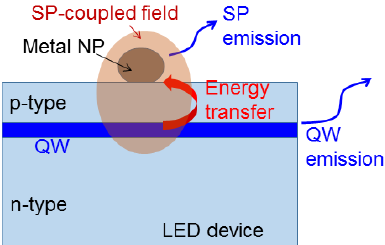
Figure 1. Schematic illustration of an SP coupling process between the SP resonance of a surface metal NP and a QW in an LED device showing the energy transfer from the QW into the SP resonance.